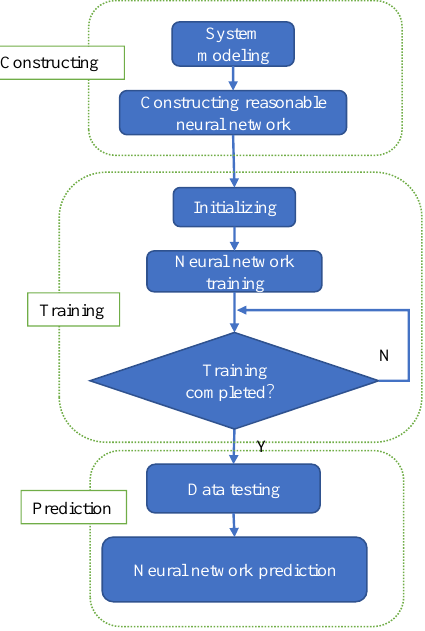
Figure 9. BP neural network structure.